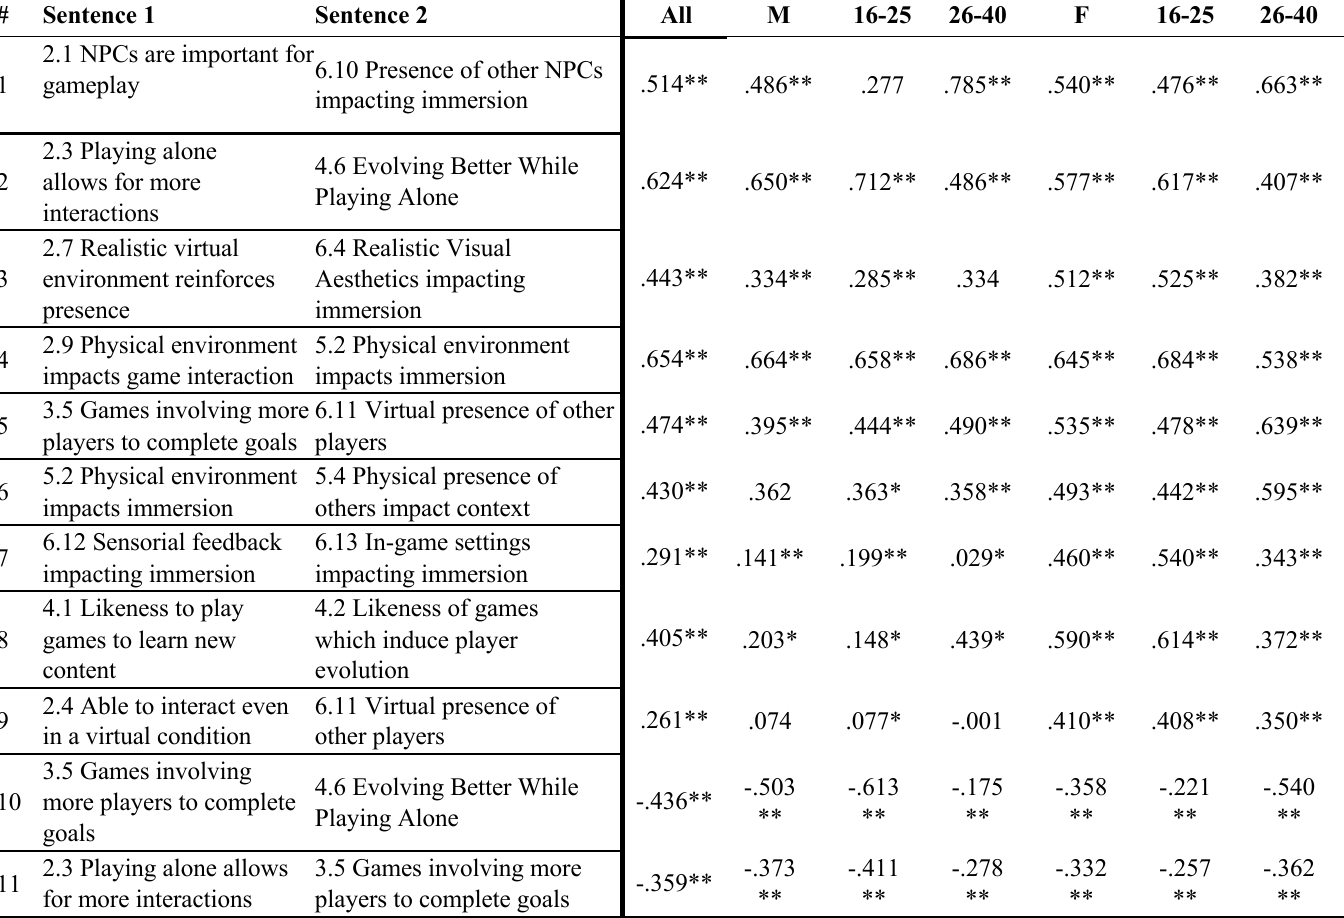
Table 3. Correlations on groups by gender and